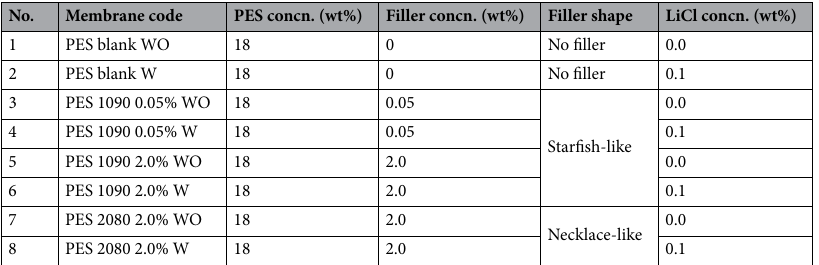
Table 1. Coded name and composition of the fabricated blank and magnetic mixed matrix poly(ethersulfone) (PES) membranes.